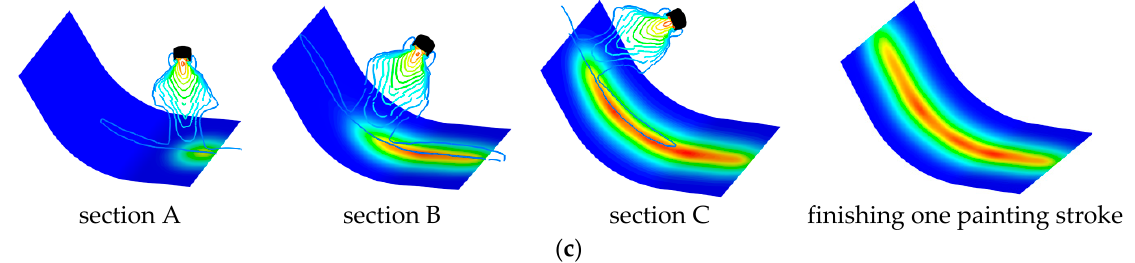
Figure 6. Contours of the film thickness and the paint velocity of dynamic painting the three arc connecting surfaces (( a – c ) represent arc connecting surfaces with the angles of 60, 90 and 120 degrees; the four figures in a line show the situations of the nozzle moving and painting in section A, B, C and finishing the painting).